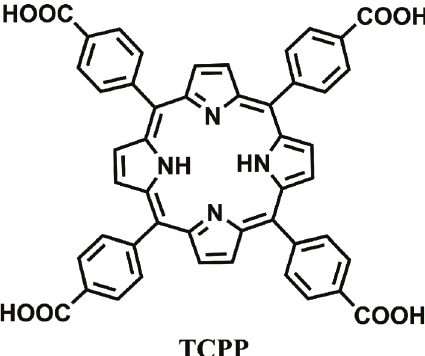
Figure 1. Meso -(4-carboxyphenyl)porphyrin (TCPP) used in this